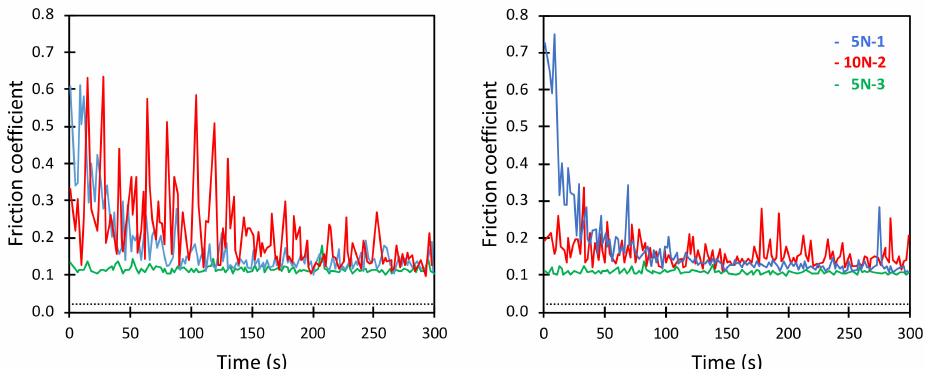
Figure 7. Friction coefficient between borosilicate surfaces across a DPPC/HA mixture as a function of time. The DPPC concentration was 0.5 mg/mL and the HA concentration was also 0.5 mg/mL. Two sets of experiments are shown. Numbers 1, 2 and 3 displayed after the load (5 N or 10 N) report the order in which the load was applied. The black dotted line corresponds to the friction coefficient of 0.02, similar to that observed at the